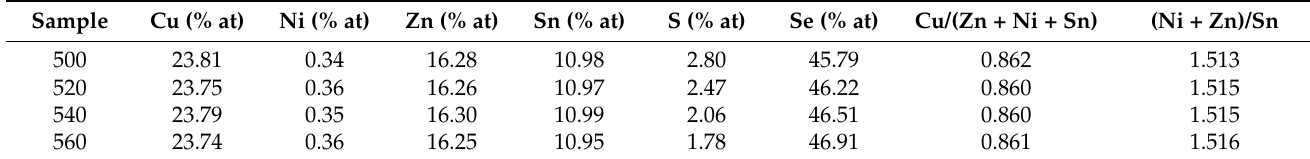
Table 1. EDS results of the CNZTSSe films selenized at various temperatures.